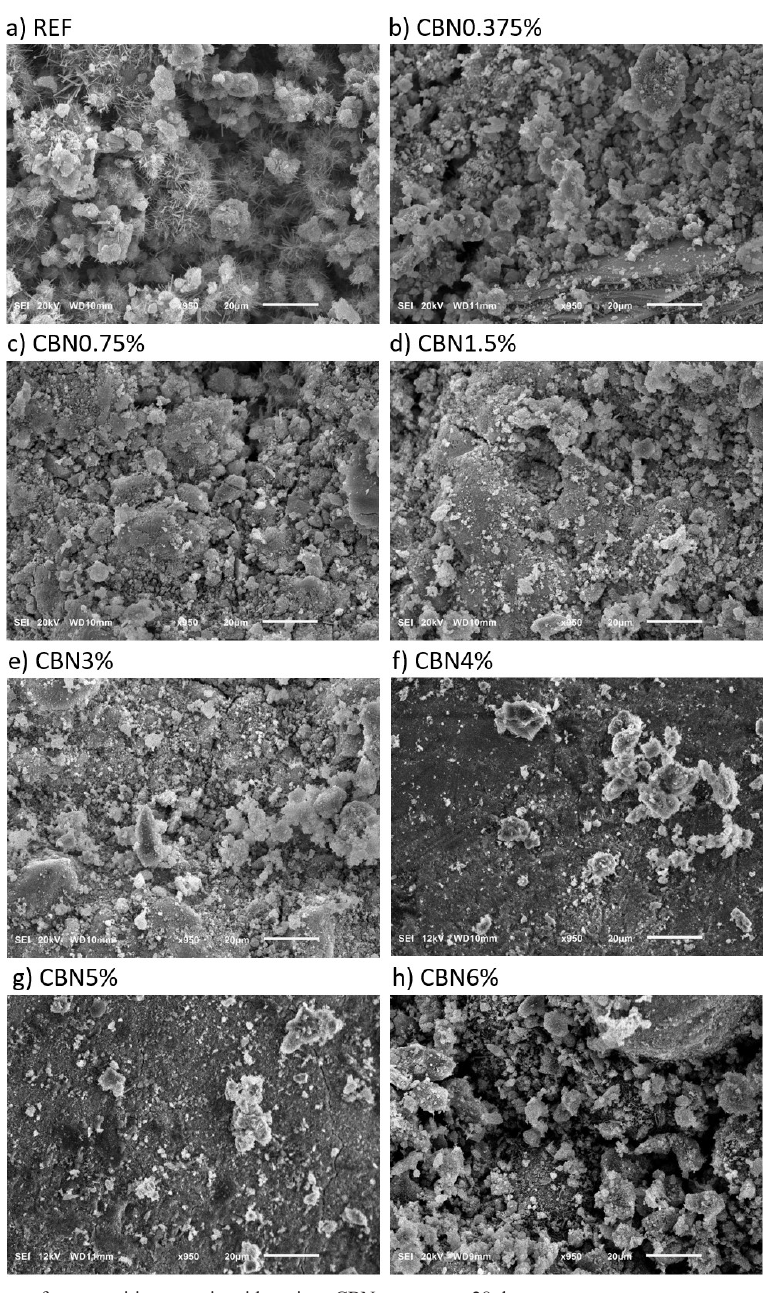
Figure 8. SEM images of a cementitious matrix with various CBN contents at 28 days.